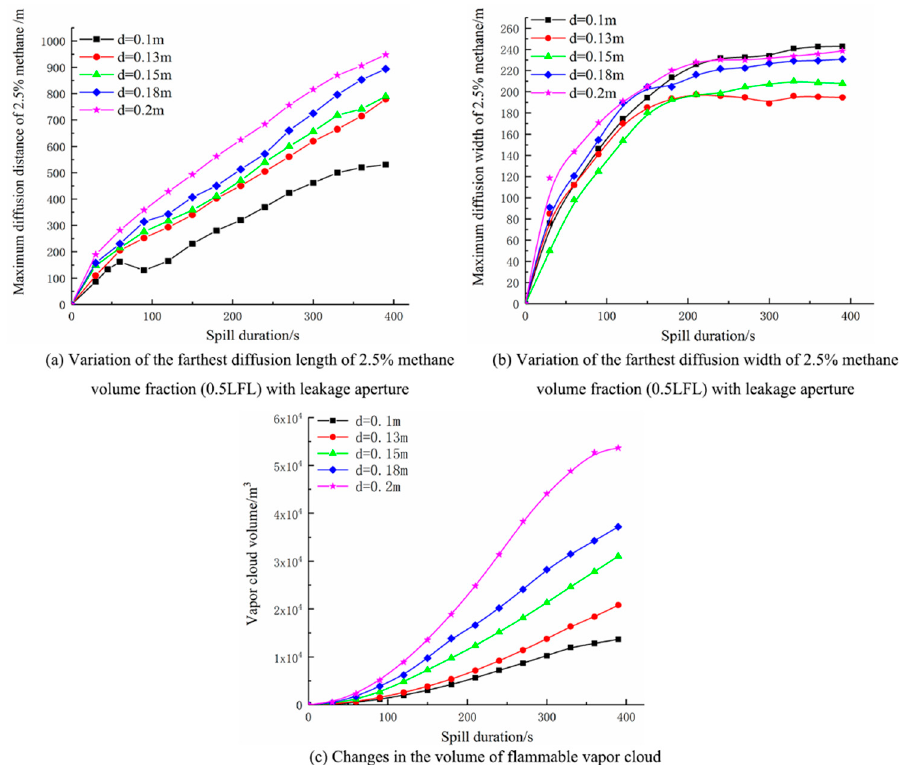
Figure 11. Variation of the farthest moving distance and volume of flammable vapor clouds with leakage time under different leakage apertures. ( a ) Variation of the farthest diffusion length of 2.5% methane volume fraction (0.5LFL) with leakage aperture; ( b ) Variation of the farthest diffusion width of 2.5% methane volume fraction (0.5LFL) with leakage aperture; ( c ) Changes in the volume of flammable vapor cloud.